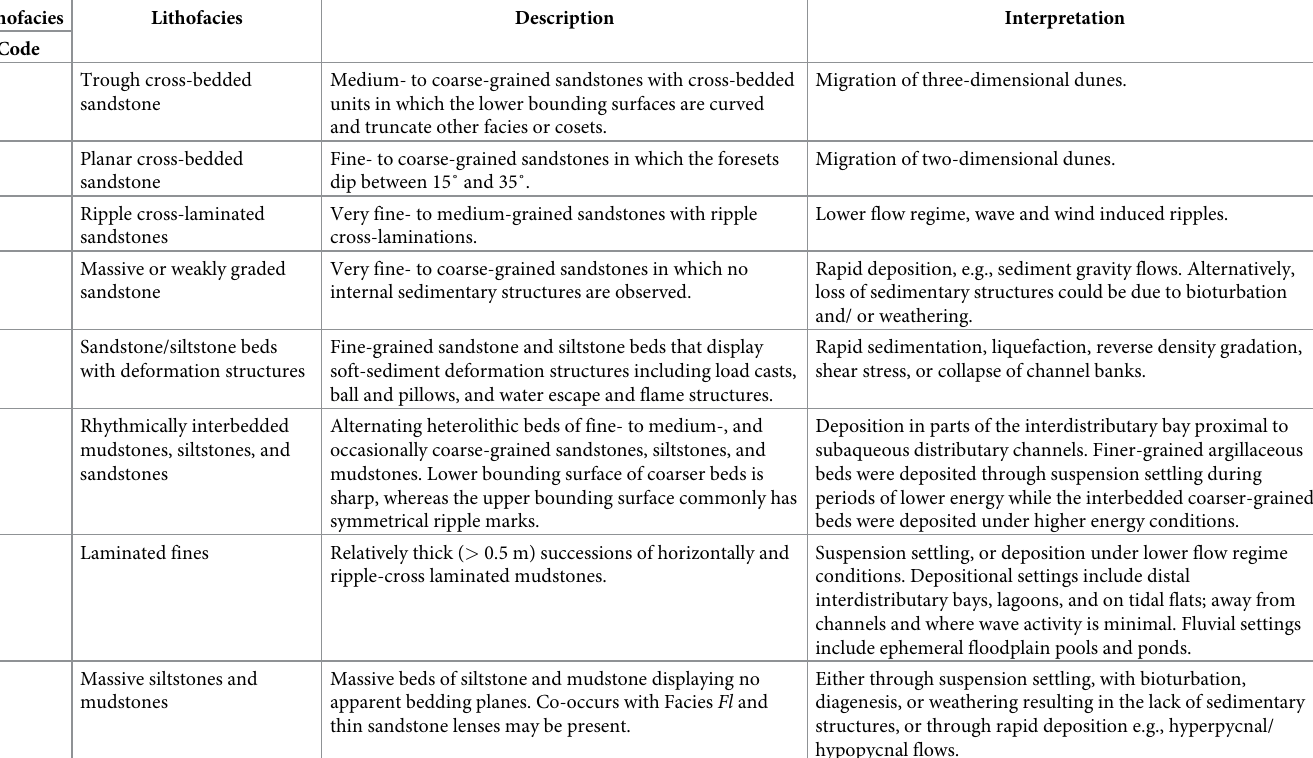
Table 1. Descriptions and interpretations of lithofacies types [modified after Miall [60]; � denotes newly erected lithofacies types from Groenewald et al . [37]] from the studied stratigraphic interval.